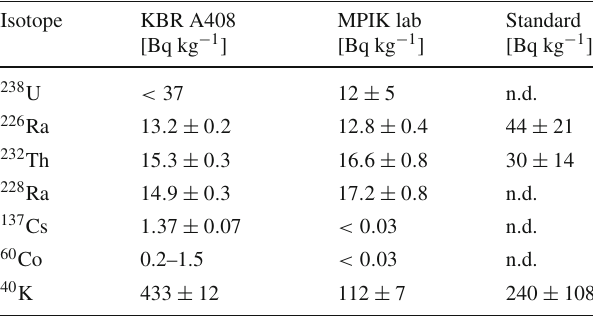
Table 2 Activity of concrete samples from room A408 and the MPIK laboratory, determined by HPGe spectrometer screening measurements at the underground laboratory in Heidelberg. The standard values are mean values from the activities of concrete from several countries